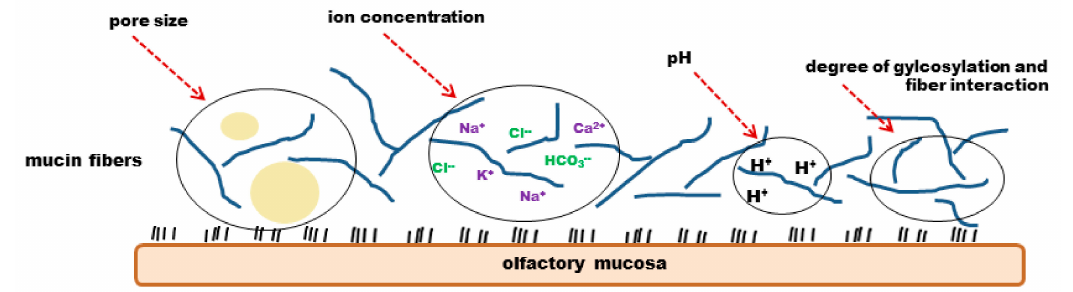
Figure 6. Physicochemical properties of mucus. The viscoelasticity and permeability of mucus is dependent of the degree of glycosylation and fibre interaction, as well as of the pore size, ion concentration and